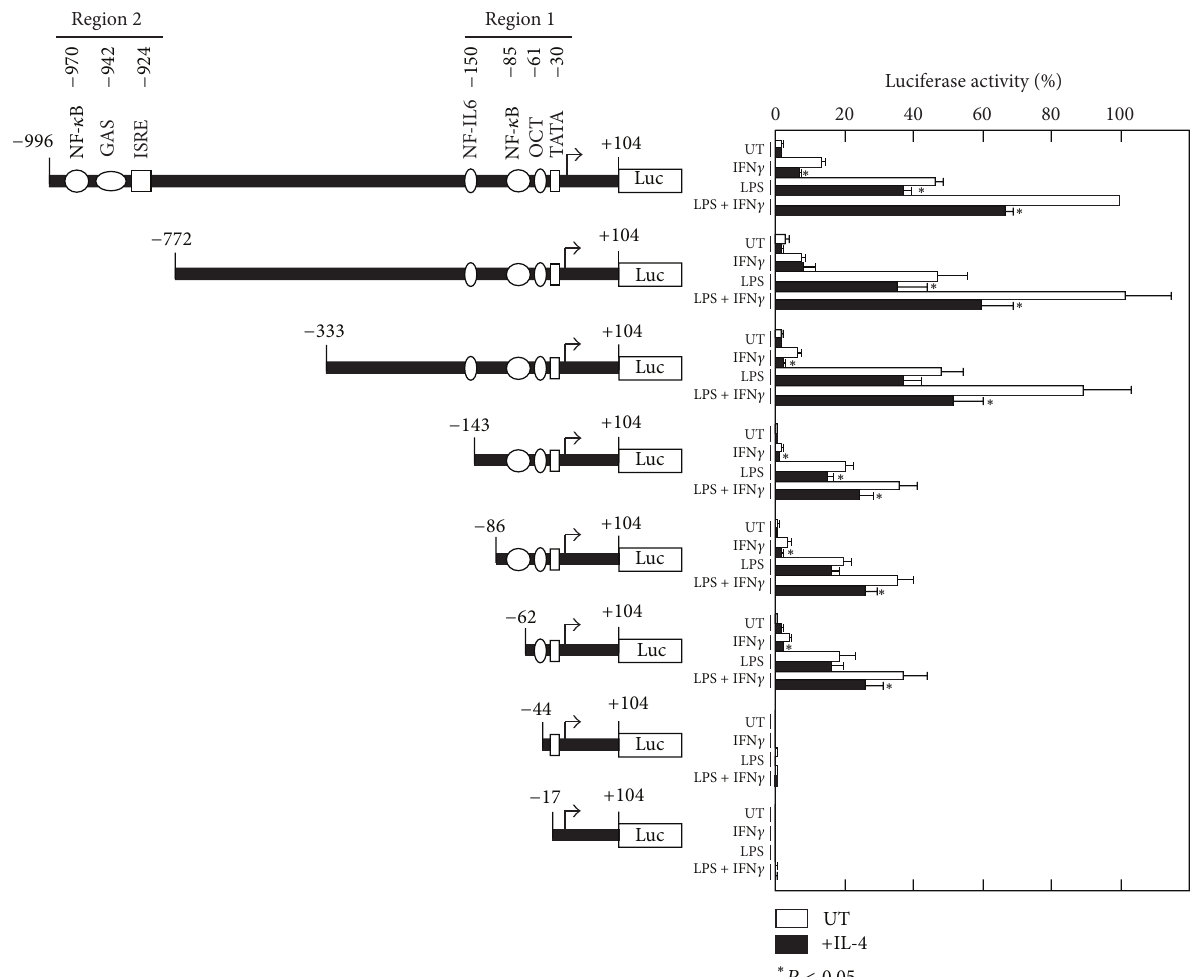
Figure 3: Deletion analysis of the mouse Nos2 enhancer/promoter region by luciferase reporter assays in RAW264.7 cells. The diagram on the left shows the wild-type (pNOS-996) and deletion constructs of the Nos2 luciferase reporter. The numbers above the enhancer/promoter region refer to the nucleotide positions relative to the transcriptional start site of the mouse Nos2 gene. NF- 𝜅 B, nuclear factor kappa B; GAS, gamma-IFN activation sequence; ISRE, interferon-stimulated responsive element; NF-IL-6, nuclear factor IL-6; OCT, octamer transcription factor; TATA, TATA-box. RAW264.7 cells were transiently transfected with wild-type or mutant Nos2 luciferase reporter constructs. Twenty- four hours after transfection, the cells were either left untreated (UT) or treated with IL-4 (10ng/mL) for 30min prior to stimulation with IFN 𝛾 (10ng/mL) and/or LPS (100ng/mL) for 8 hours before measurement of the luciferase activity. The relative luciferase activities are shown as percentages of the activity in cells transfected with the wild-type construct (pNOS-996) and stimulated with IFN 𝛾 and LPS. Each column and bar represents the mean ± SEM of five independent experiments. The asterisks denote a statistically significant difference compared to the cultures with IL-4 ( 𝑃 < 0.05 , Student’s 𝑡